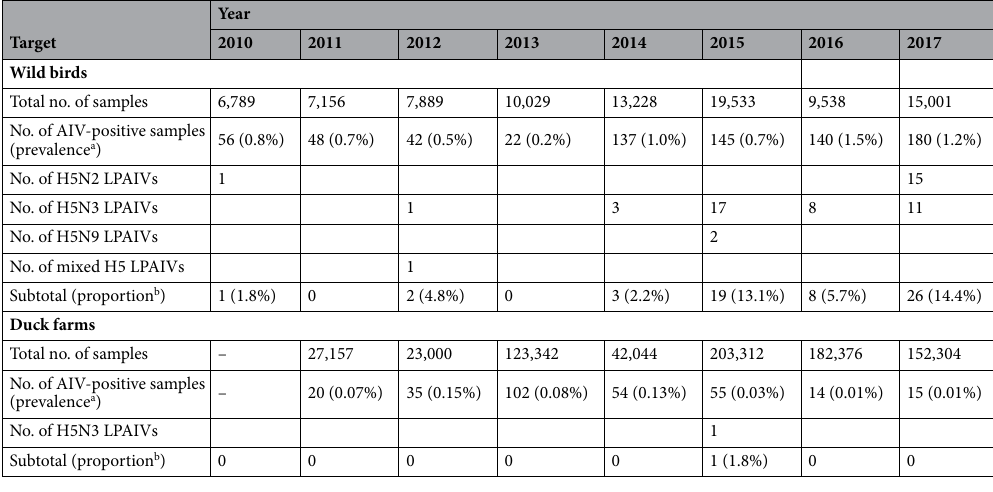
Table 1. Numbers of avian influenza viruses (AIVs) isolated from wild bird habitats and duck farms in South Korea between 2010 and 2017. a No. of AIV-positive samples/total no. of samples (%). b No. of H5 LPAIVs/no. of AIV-positive samples (%). LPAIV, low pathogenic